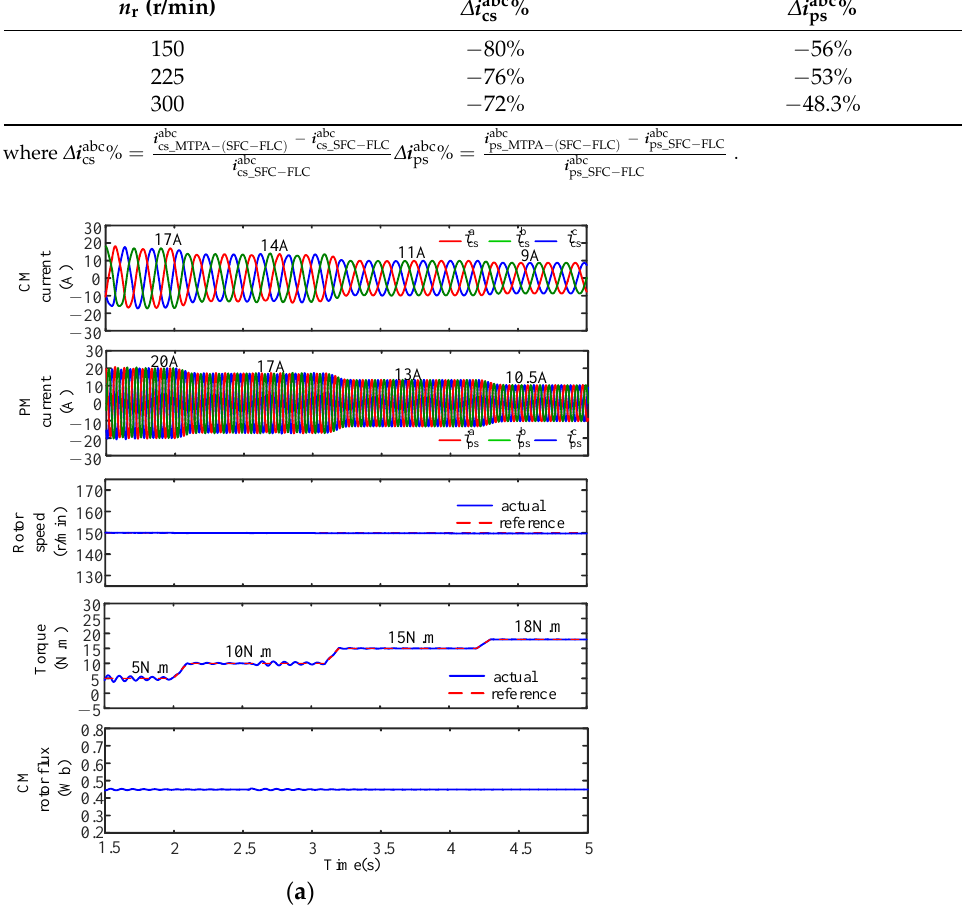
Figure 8. Simulation data when the load torque is constant and the speed changes.